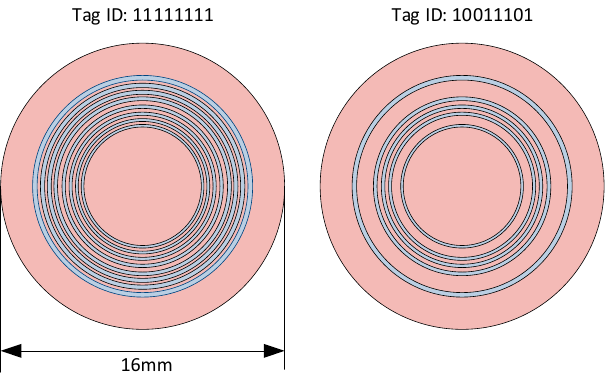
Figure 7. Slot Ring Resonator Tags—Adapted from Reference [106].